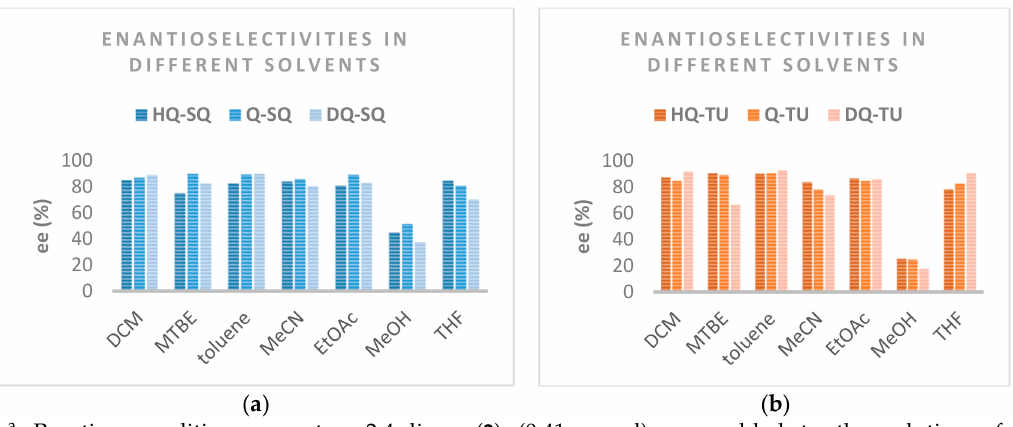
Figure 3. Enantioselectivities given in di ff erent solvents when squaramides ( a ) or thioureas ( b ) were applied in Michael